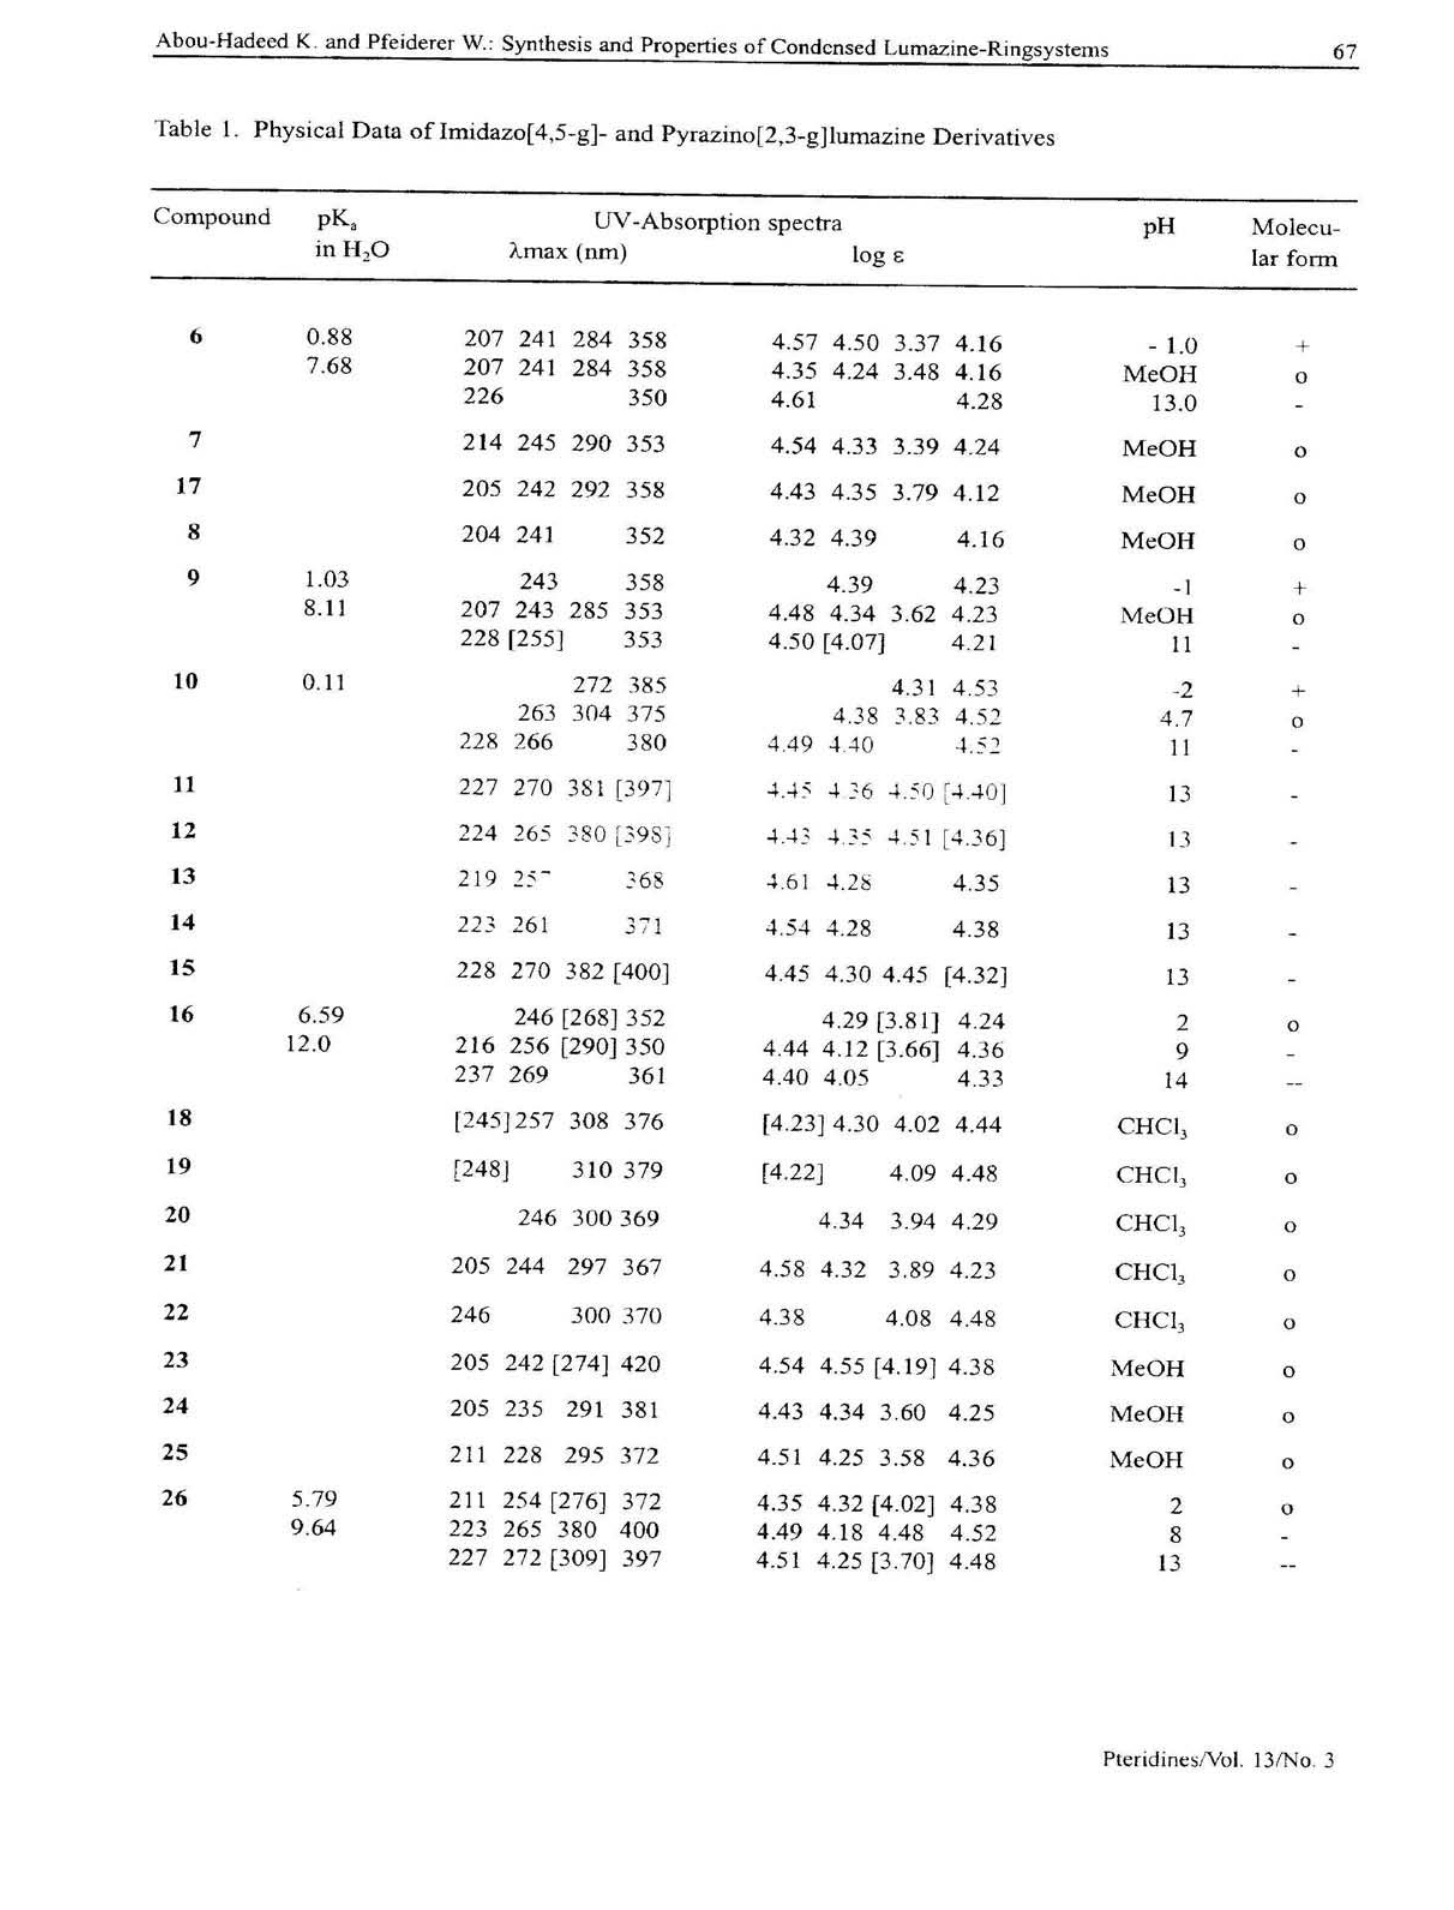
Table 1. Physical Data of Imidazo[4,5-g]- and Pyrazmo[2,3-g]lumazine